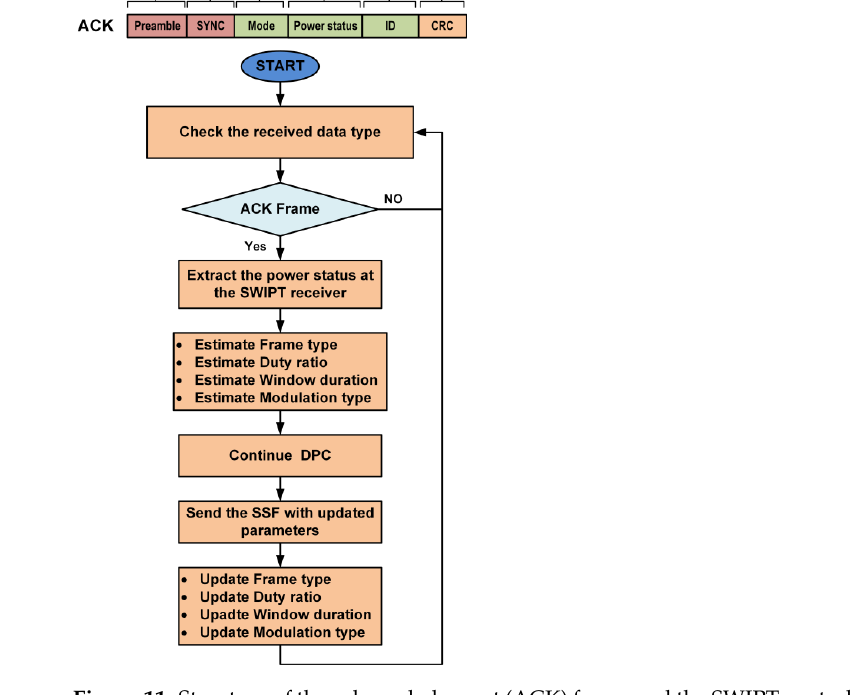
Figure 13. Transmission of the ACK frame after the BBP at the SWIPT receiver.